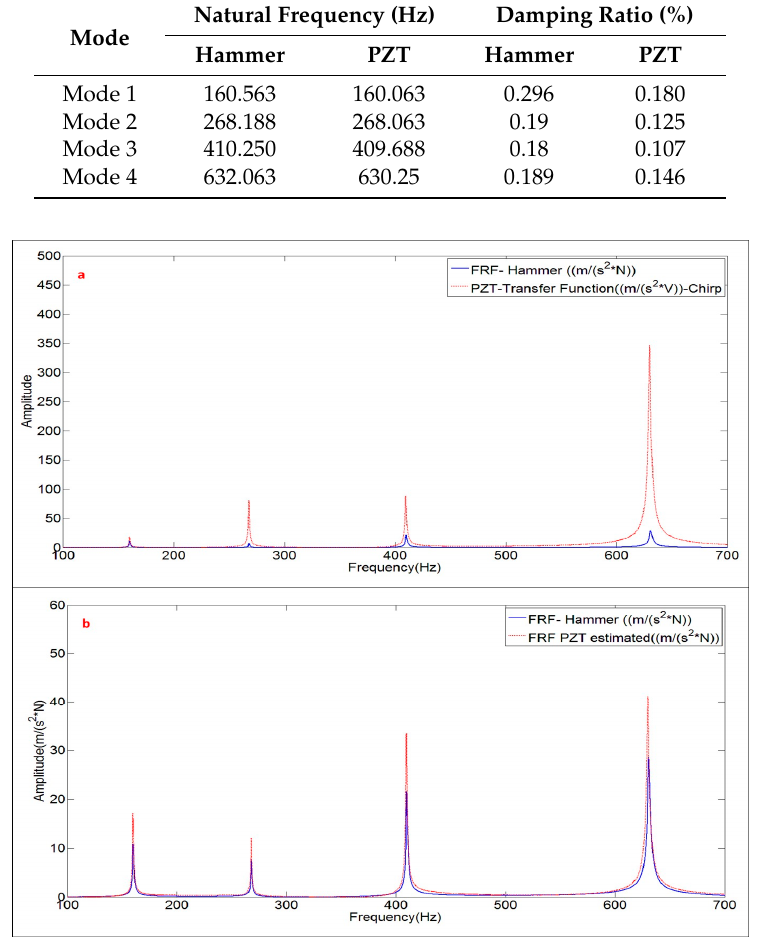
Table 5. Comparison of the modal parameters (Natural Frequency and Damping Ratio) between PZT excitation and Hammer.